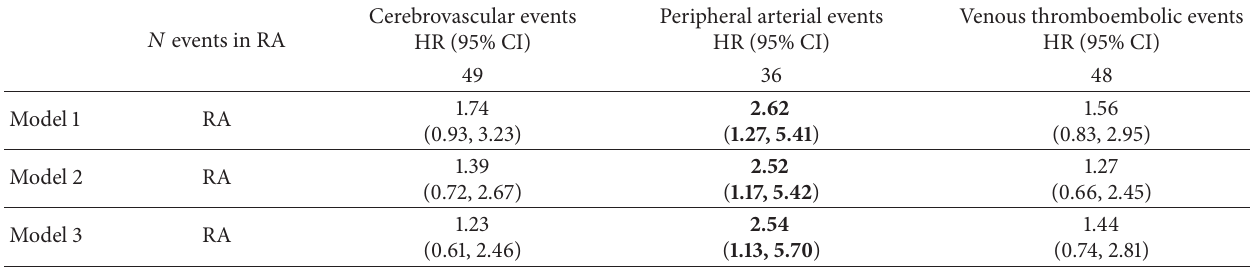
Table 4: Associations between hyperuricemia and noncardiac vascular disease in patients with rheumatoid arthritis (RA). Data on subjects without RA were omitted as they were only available for part of the study period (1995–2007). 𝑁 events in